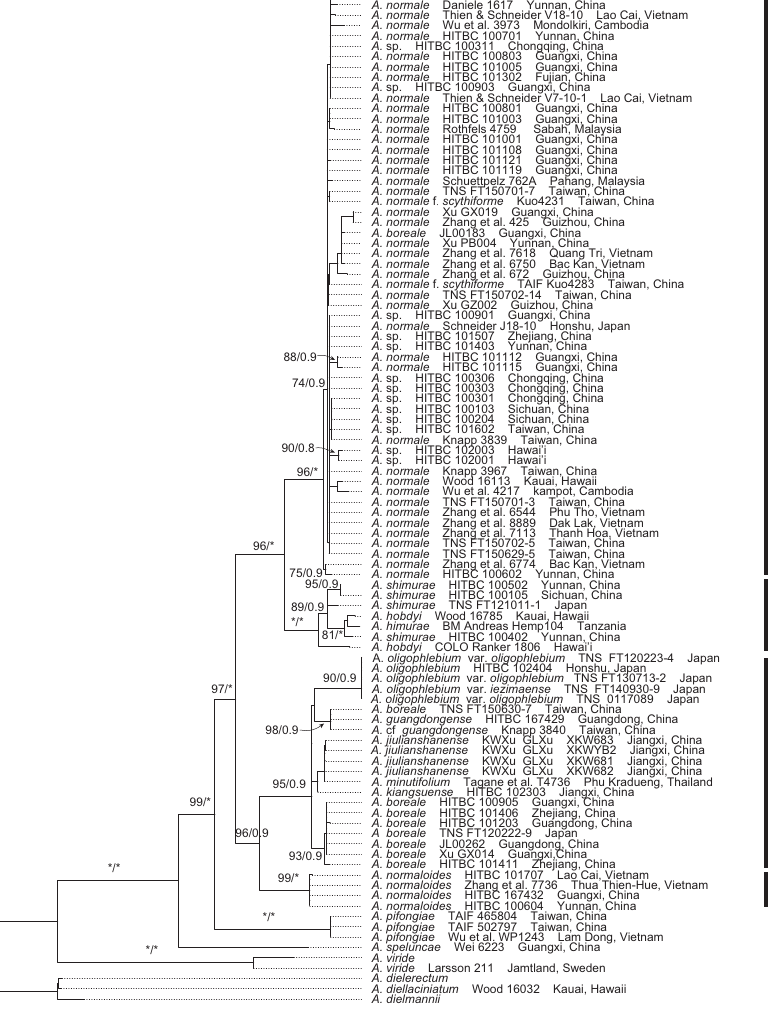
Figure 3. The phylogenetic position of Asplenium jiulianshanense K.W.Xu & G.L.Xu based on seven plastid markers ( atpB , rbcL , rps4 , rps4-trnS , trnL , trnL-F , and trnG ). The numbers associated with branches are maxi- mum likelihood bootstrap (MLBS) values followed by Bayesian inference posterior probabilities (PP). “*” indi- cates MLBS = 100% or PP = 1. Black vertical bars indicate those major clades identified by Chang et al. exospore length 37‒43 µm, while the latter has rachises without gemmae near the apex, pinnae 8‒20(‒22) pairs, pinna margins entire to sinuate, exospore length 31‒36 µm. Type. China. Jiangxi province, Ganzhou City, Jiulianshan National Nature Reserve, 256 m, 24°56'2.04"N, 114°49'23.44"E, 8 Jun 2021, Guo-Liang Xu & Ke-